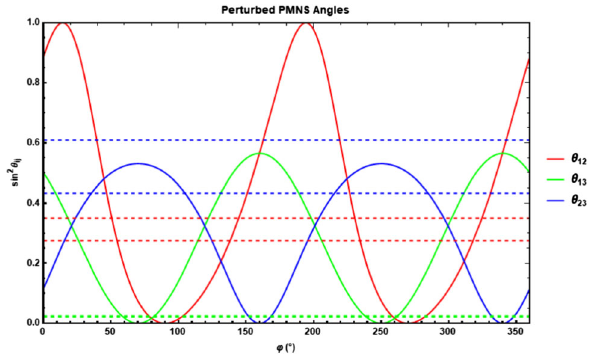
Fig. 5 PMNS matrix resulting from the corrections induced by the second operator in Eq. (4.32). A good agreement at a 3 σ level can be achieved for ϕ (cid:16) 59 ◦ or ϕ (cid:16) 239 ◦